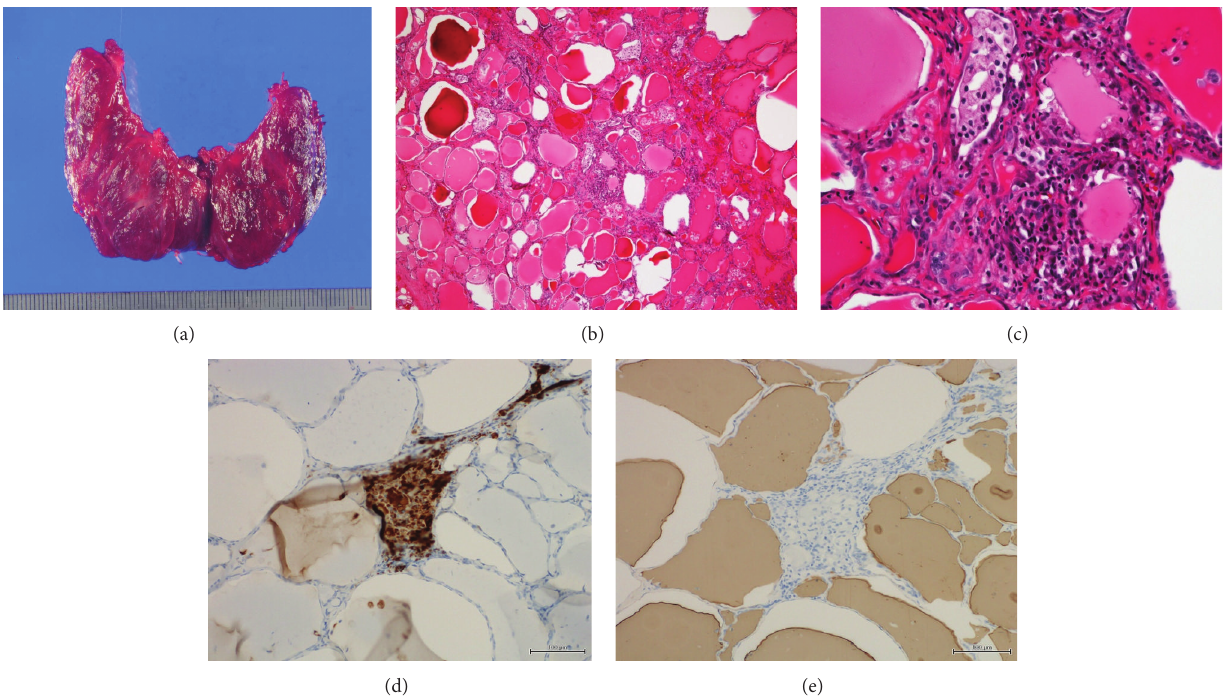
Figure 4: (a) Gross pathological findings of the excised thyroid gland. (b, c) H-E staining of the thyroid gland in low-power (b) and high- power fields (c). Several sizes of follicle were regularly lined with flattened follicular epithelium. The lumen was filled with colloid. Scattered disrupted follicles with enlarged epithelium and cytoplasmic vacuoles were observed (b). Macrophages had infiltrated and multinucleated giant cells were found in follicular lumen (c). Immunostaining with anti-KP-1 (CD68) antibody (d). Immunostaining with antithyroglobulin antibody